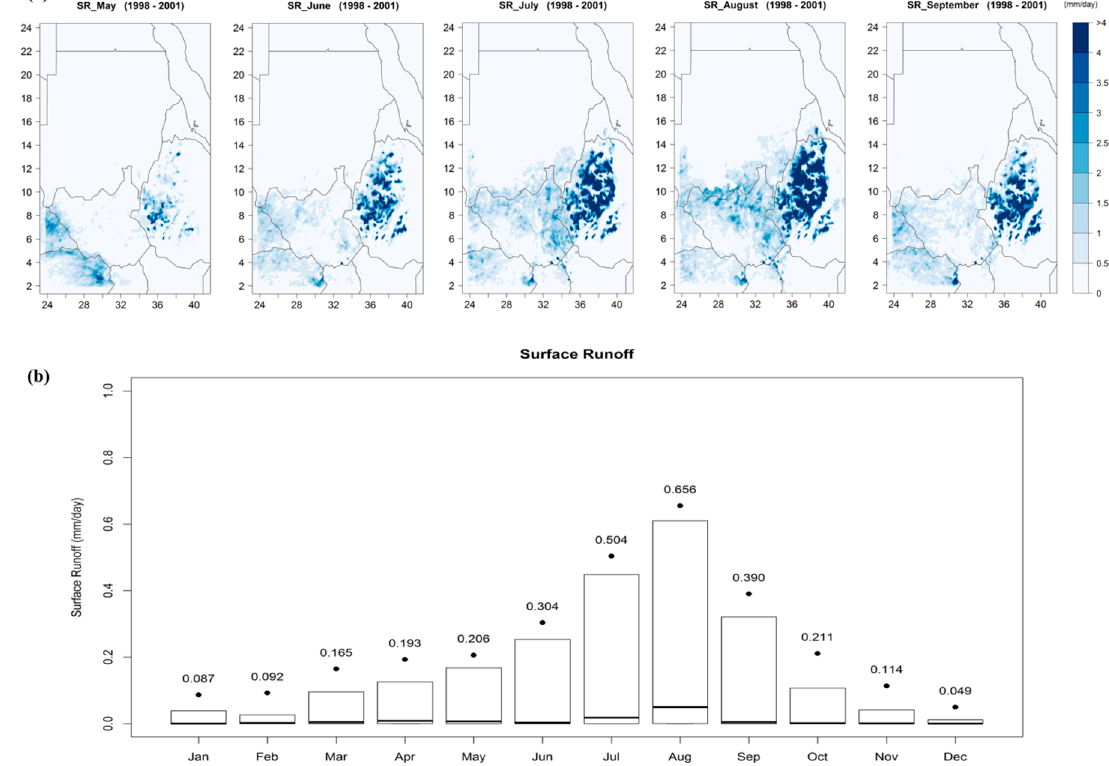
Figure 9. ( a ): average surface runoff over the ENB region for the months with the highest means as simulated by the WRF model during the period 1998–2001, Longitude on the horizontal axis and latitude on the vertical axis. ( b ): boxplots of the monthly runoff over the ENB region indicating the means for each month.